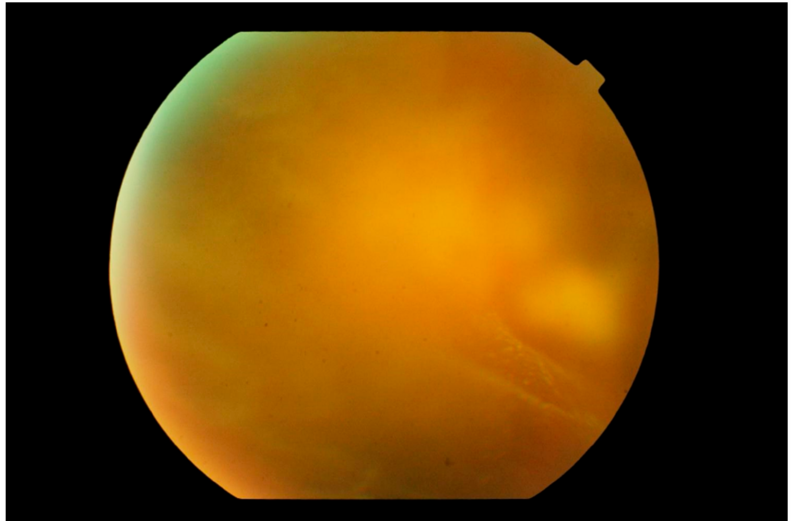
Figure 2. Photograph of the peripheral fundus showing the “aurora borealis” sign caused by lymphoma cell infiltration along the vitreous fibrils creating streaks of opacity. In the background, a multinodular yellowish mass is just